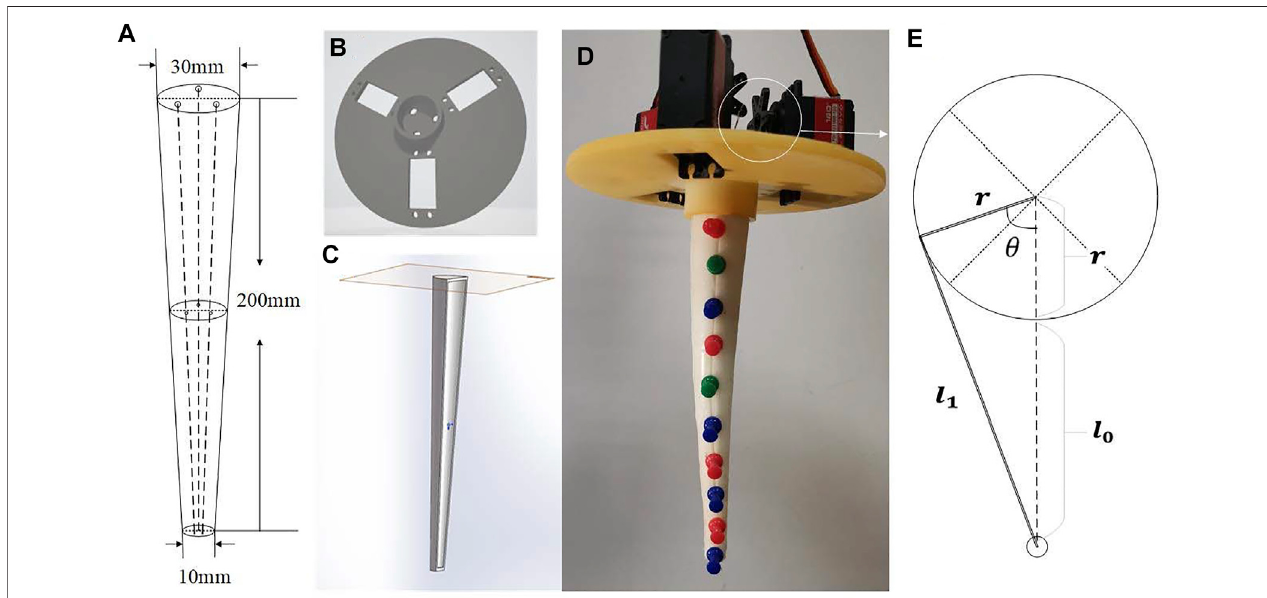
FIGURE 1 | Design and fabrication of the soft arm. (A) Structure design of a cable-driven soft arm (B) The mold of the soft arm (C) The mold for bracket (D) The assembly of the soft arm (E) The link relationship of the driving cable.